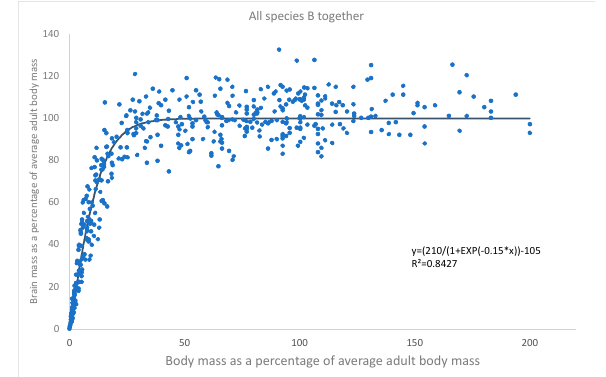
( a ) Model B of brain size growth relative to body size growth, all